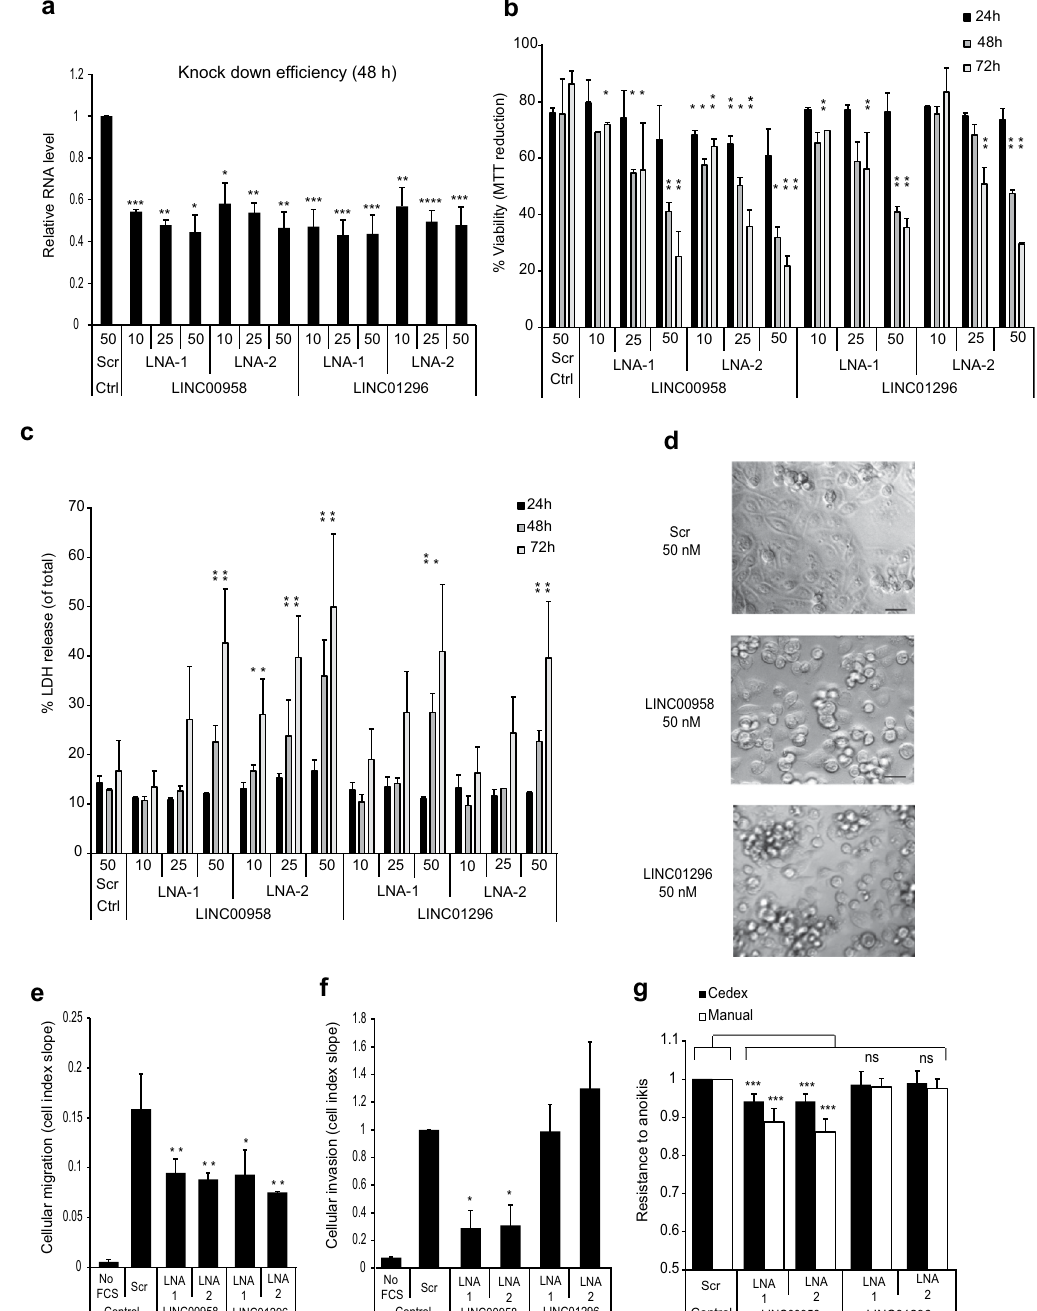
Figure 3. Functional effects of LINC00958 or LINC01296 knock-down in FL3 cells. FL3 cells were transfected either with a non-targeting LNA TM GapmeR (Scr) or 2 different LNA TM GapmeR separately targeting LINC00958 or LINC01296 (LNA-1 and LNA-2) at the indicated concentrations (10, 25 or 50 nM). ( a ) Dose-dependent knock-down efficiency was verified by RT-qPCR 48 hours post-transfection. Results were normalized to Scr. ( b ) Dose-dependent viability was assessed by MTT reduction 24, 48 and 72 h post-transfection and expressed as percentage compared to viability of untransfected cells. ( c ) Dose-dependent cell death was determined by the LDH release assay 24, 48 and 72 h post-transfection and depicted as percentage of released LDH out of total cellular LDH. ( d ) Cell morphology was examined upon candidate knock-down by phase contrast microscopy 72 h post-transfection (25x magnification, scale bar 40 μ m). Cellular migration ( e ) and invasion ( f ) of transfected FL3 cells (25 nM LNA TM GapmeR). ( g ) Anoikis resistance upon candidate knock-down (25 nM LNA TM GapmeR). Cell viability was assessed by both automatic and manual cell counting. Results were normalized to Scr. FCS: Fetal calf Serum. Columns in ( b , c and g ) represents the average of two or three independent experiments, each measured in three to five replicates. Bars: SD and * p < 0.05, ** p < 0.01, *** p < 0.001 and **** p <